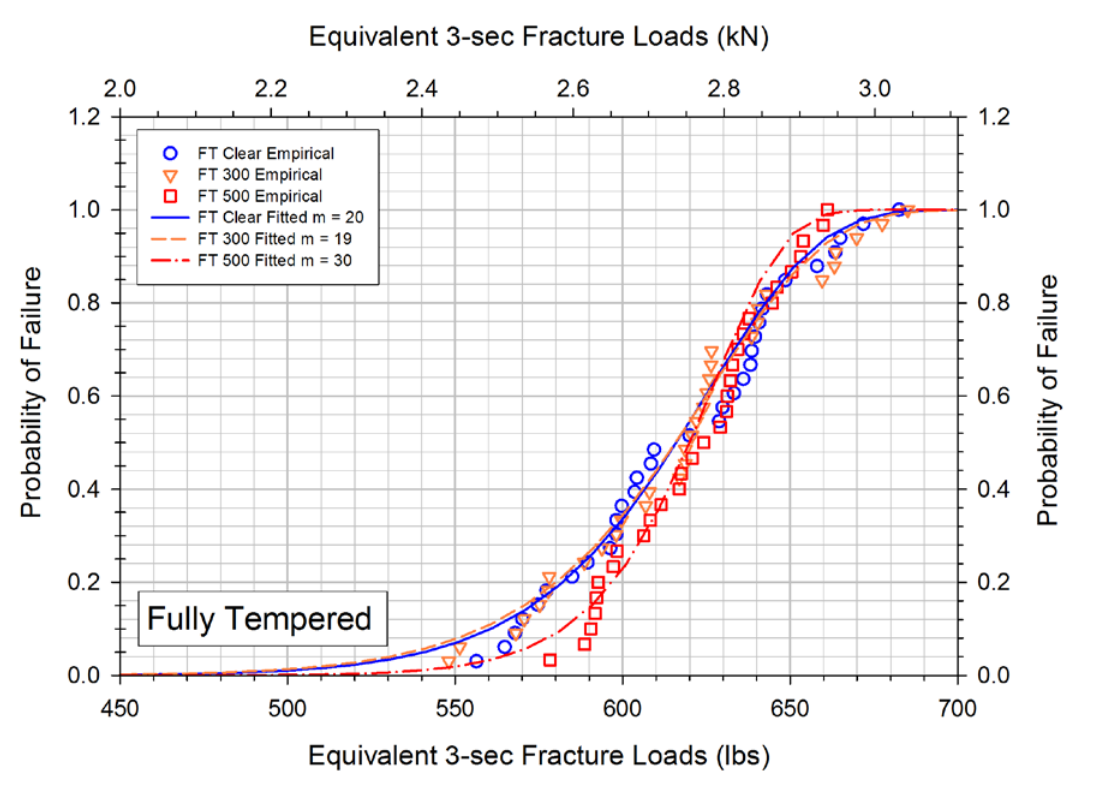
Figure 5. Cumulative distribution function for the probability of failure for clear FT, OPACI-COAT-300®, and OPACI-COAT-500®